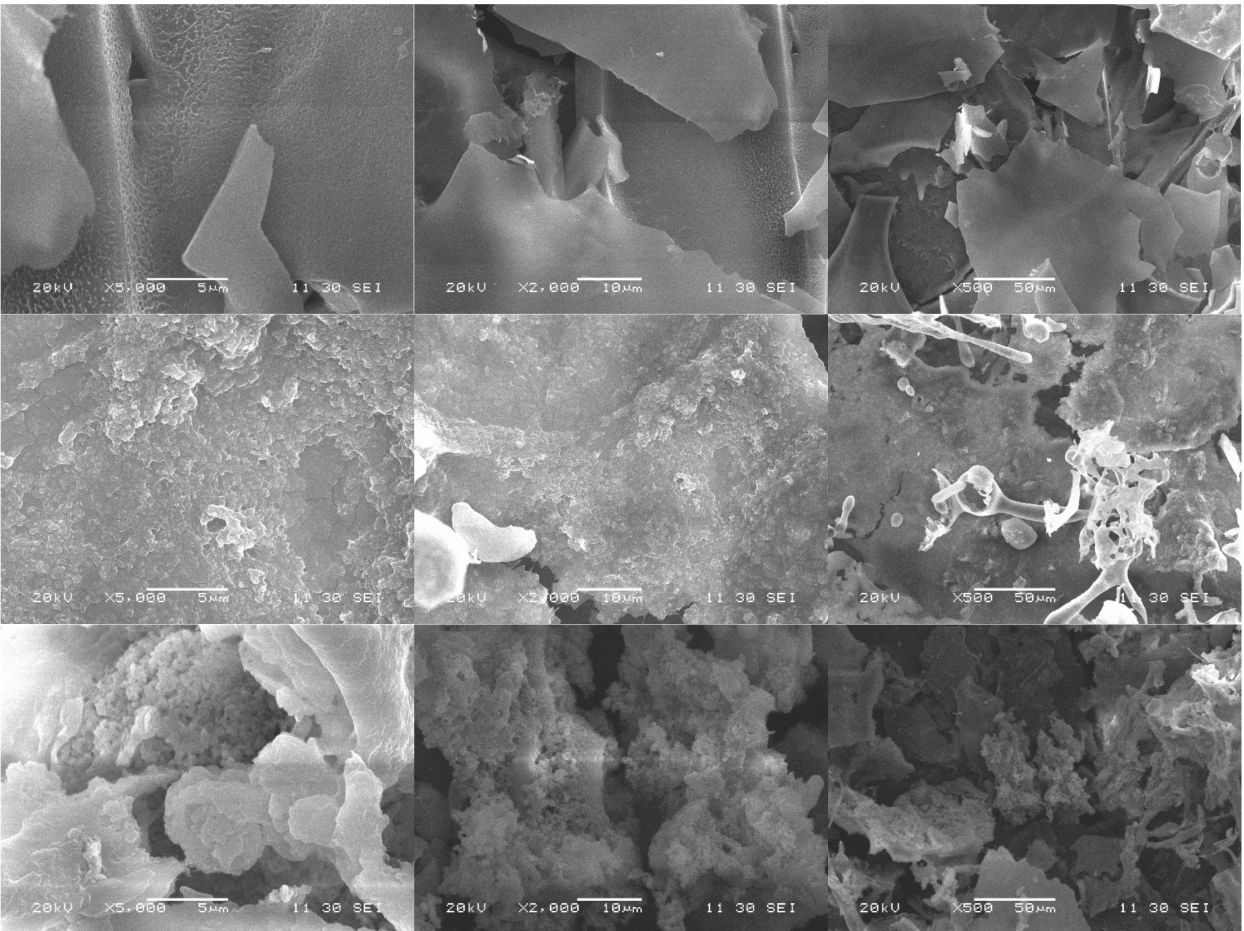
Figure 5. SEM images of yam polysaccharide fractions. The three lines of images from top to bottom represent the SEM results of YPN, YPA-II and